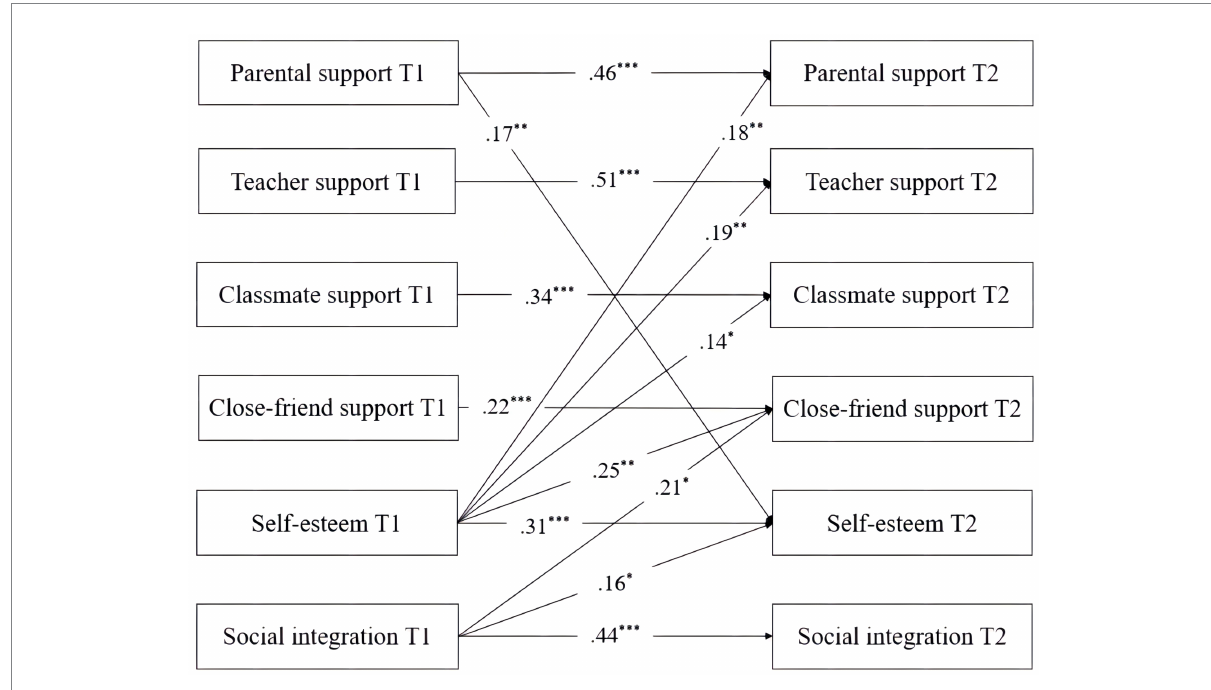
FIGURE 1 The cross-lagged model of perceived social support, self-esteem, and social integration. * p < 0.05, ** p < 0.01, *** p <